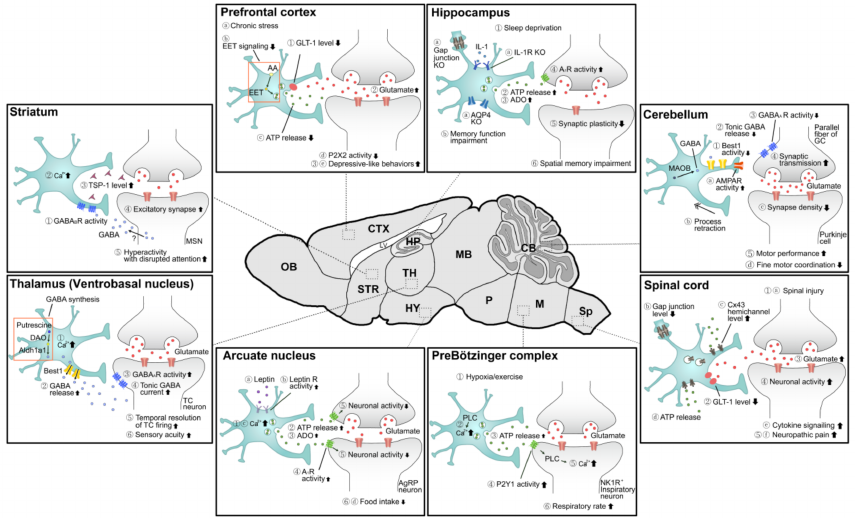
Figure 2. Schematic showing the intracellular signaling pathways in astrocytes and intercellular interactions between astrocytes and neurons. Separate pathways in a brain region are distinguished by numbering and alphabetical arrangement. Detailed explanations and references can be found in the text. AA, arachidonic acid; ADO, adenosine; AgRP, agouti-related peptide; AMPAR, α -amino-3-hydroxy-5-methyl-4-isoxazolepropionic acid-type glutamate receptors; AQP4, aquaporin 4; ATP, adenosine triphosphate; Best1, bestrophin 1; CB, cerebellum; CTX, cortex; Cx43, connexin 43; DAO, diamine oxidase; EET, epoxyeicosatrienoic acid; GABA, γ -aminobutyric acid; GAT-3, GABA transporter type 3; GC, granule cell; GLT-1, glutamate transporter 1; HP, hippocampus; HY, hypothalamus; IL-1, interleukin-1; LV, lateral ventricle; M, medulla; MB, midbrain; MAOB, monoamine oxidase B; MSN, medium spiny neuron; NK1R, neurokinin 1 receptor; OB, olfactory bulb; P, pons; PLC, phospholipase C; Sp, spinal cord; STR, striatum; TC neuron, thalamocortical neuron; TH, thalamus; TSP-1,